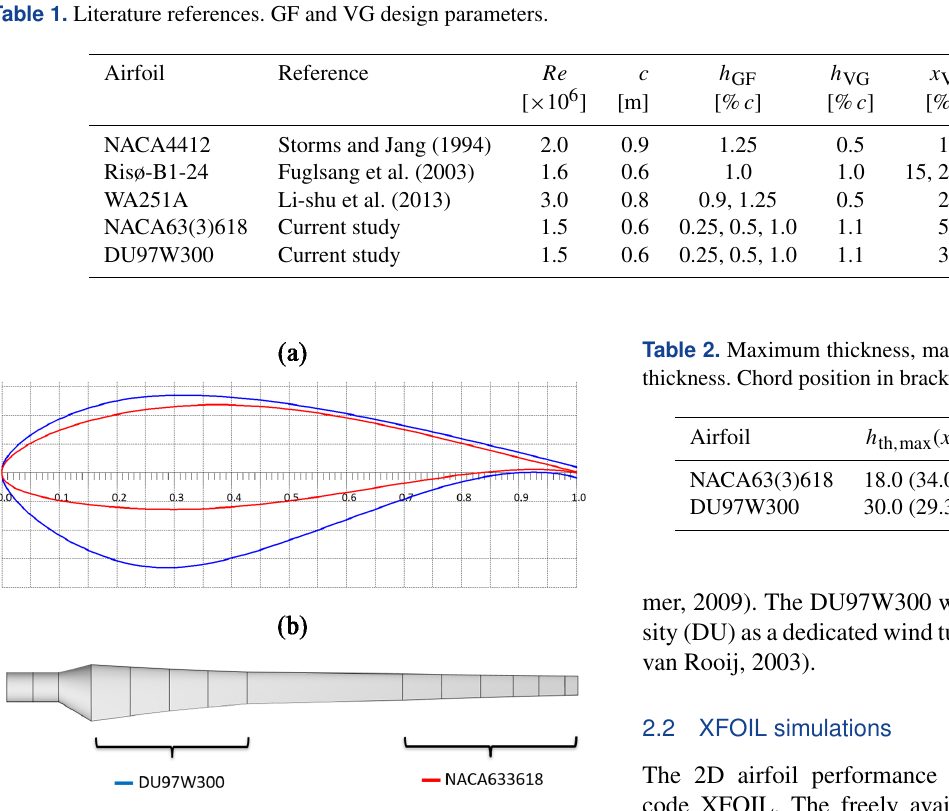
Figure 4. NACA63(3)618 and DU97W300. (a) Airfoil coordinates normalized by the chord length. (b) Airfoil position on a generic rotor blade.